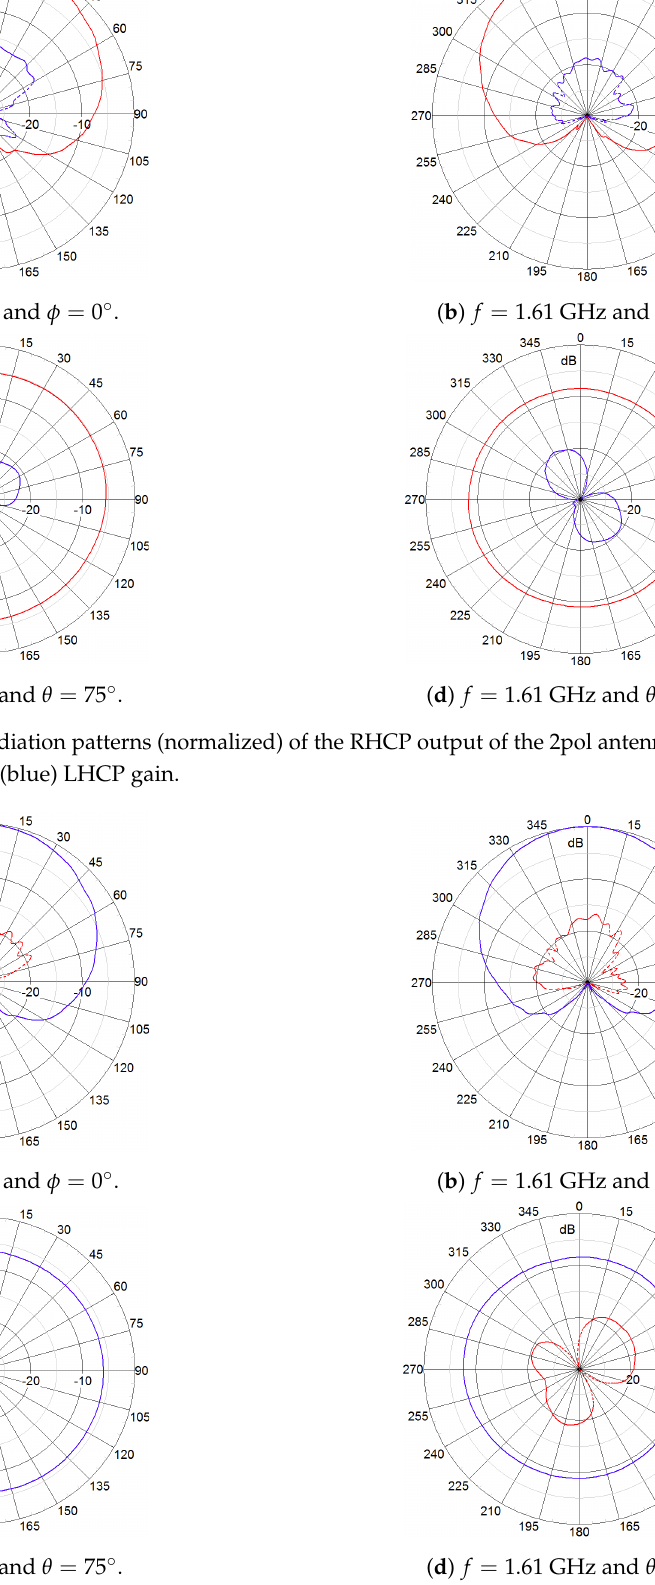
Figure 3. Measured radiation patterns (normalized) of the LHCP output of the 2pol antenna prototype. (Red) RHCP gain and (blue) LHCP